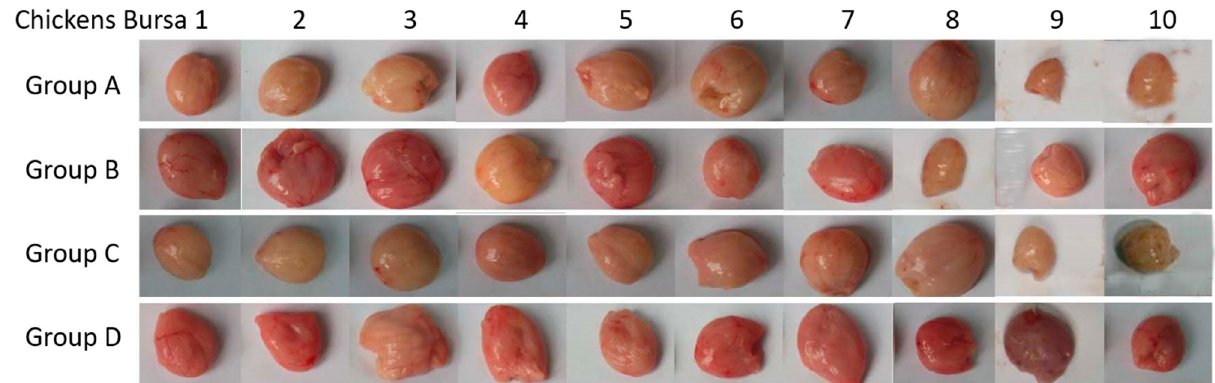
Figure 9. The histologic appearance of the bursa of Fabricius in chicks after IBDV (NJ09) challenge Chickens in group A were inoculated subcutaneously with HVT Fc-126 virus, and those in group B were inoculated subcutaneously with HVT-VP2-09 at a dose of 3000 PFU. Chickens in groups C and D were inoculated subcutaneously with 0.2 mL of PBS as controls. Six weeks after inoculation, the chickens of groups A–C were challenged with virulent NJ09 at a dose of 100 LD 50 and observed daily for 84 h to analyze the histologic appearance changes.